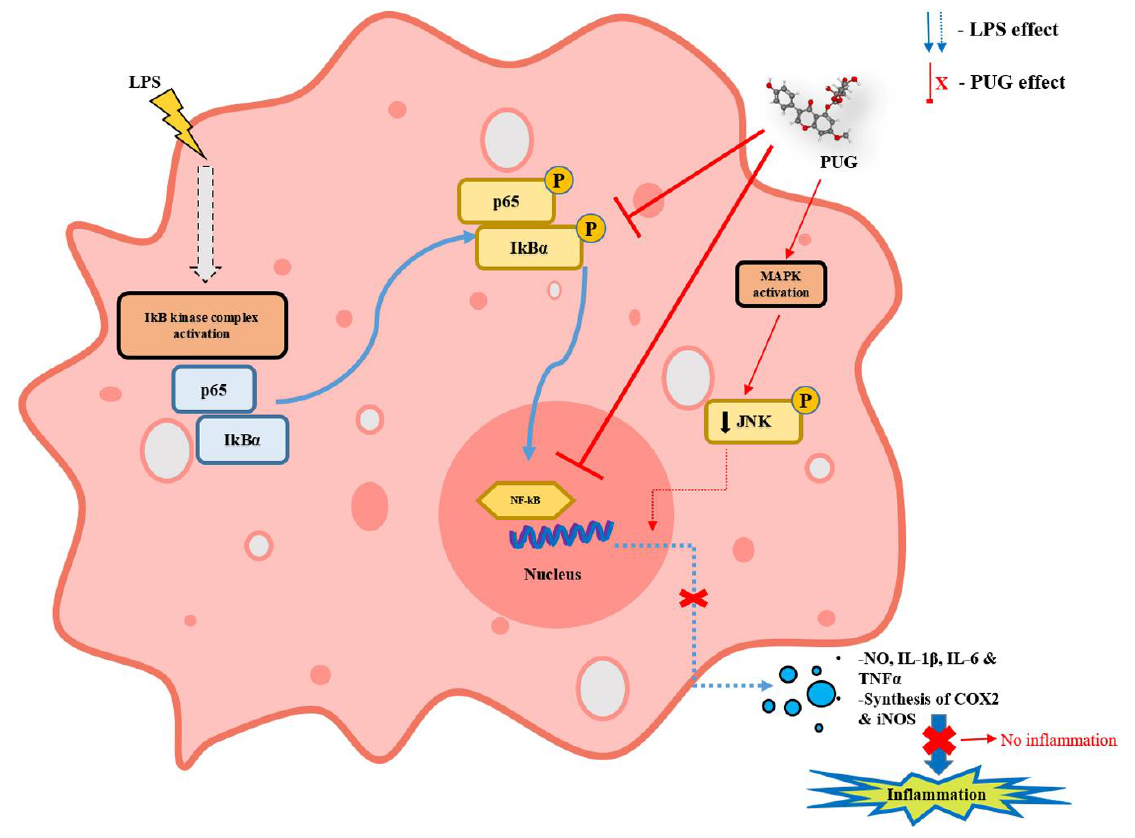
Figure 10. Schematic illustration of the anti-inflammatory action of PUG in macrophage RAW264.7 cells.